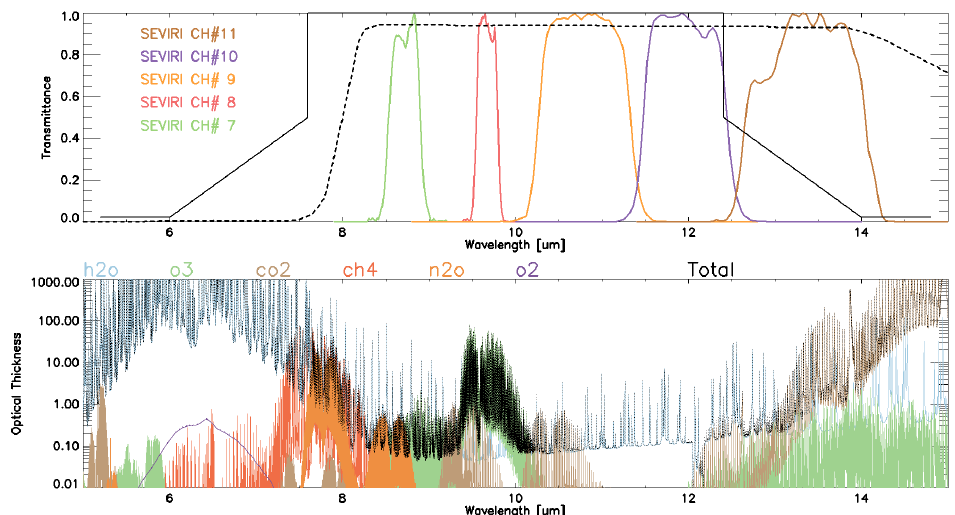
Figure 5. ( Top ) Black continuous/dotted lines: preliminary spectral response function of the Harmony panchromatic channel/sensor. Colored lines refer to the SEVIRI channels: green (channel 7), 8.7 µ m; red (channel 8), 9.7 µ m; orange (channel 9), 10.8 µ m; purple (channel 10), 12.0 µ m; brown (channel 11), 13.4 µ m. ( Bottom ) Example of optical thicknesses of the main atmospheric absorbing gases in the 5–15 µ m range (http://eodg.atm.ox.ac.uk/ATLAS/zenith-absorption, accessed on 26 June 2022).